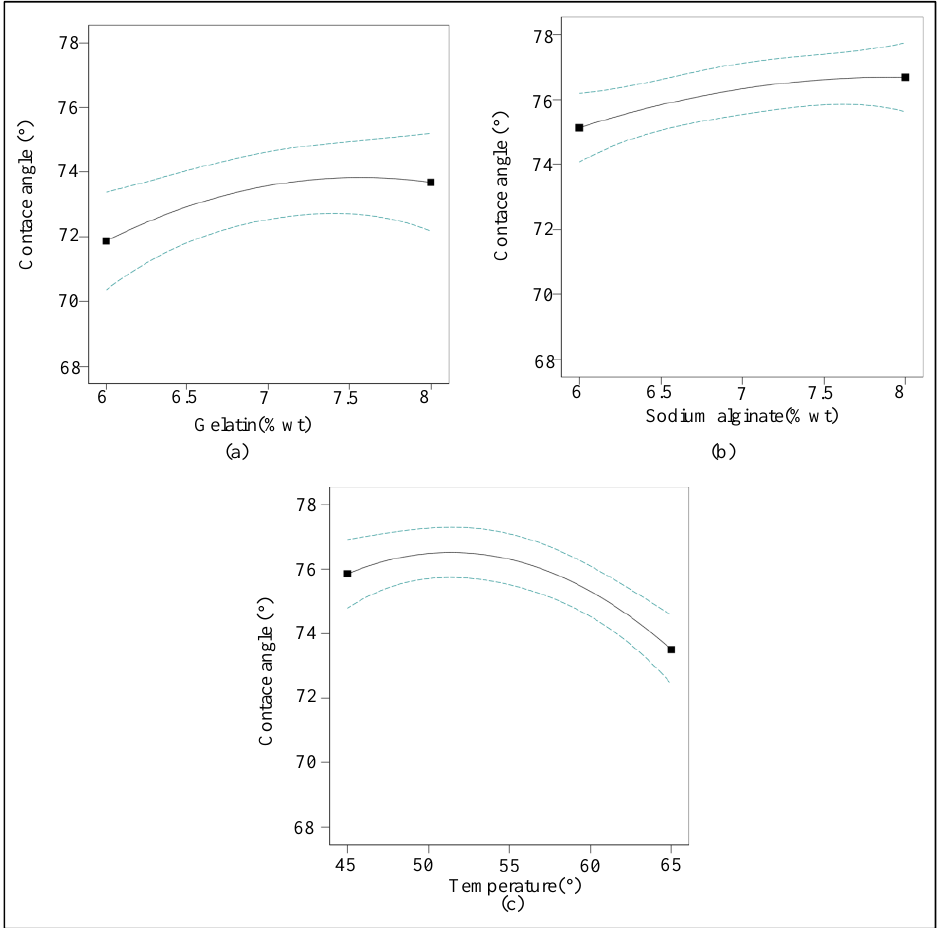
Figure 2. Effects of gelatin, sodium alginate, and temperature on hydrogel contact angles ( n = 16). ( a ) The relationship between gelatin concentration (6 – 8 wt%) and contact angle (68 – 78°). ( b ) The relationship between sodium alginate concentration (6 – 8 wt%) and contact angle (68 – 78°). ( c ) The relationship between the temperature of the mixed hydrogel (45 – 65 °C) and the contact angle (68 – 78°).